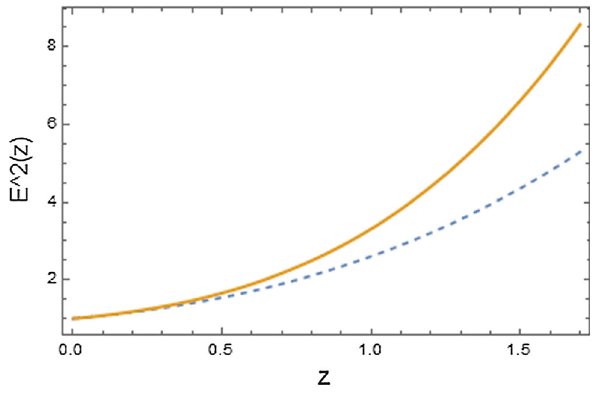
Fig. 1 Herewereconstructboth(14)(continuousline)and(15)(dahed line) using the best fit values. As is evident, for z < 0 . 5 both functions are almost identical, but they start to differs from z > 0 .